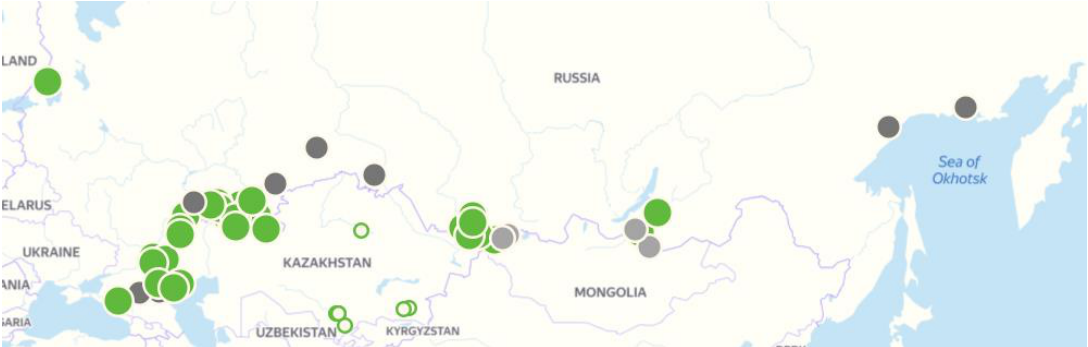
Figure 5. The locations of solar projects under Hevel management (single solar plants are marked with green color; solar plants as a part of thermal power plants are marked with grey color).